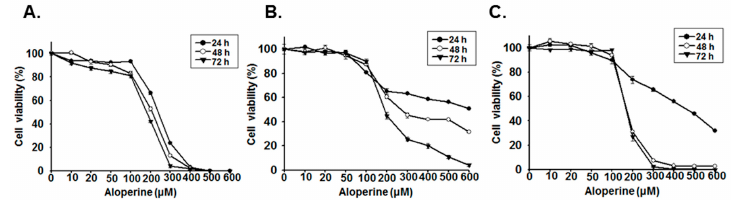
Figure 1. Suppression of human thyroid cancer cell growth following aloperine treatment. ( A ) KMH-2, ( B ) 8505c, and ( C ) IHH-4 cells were treated with aloperine at various dosages, and their viabilities